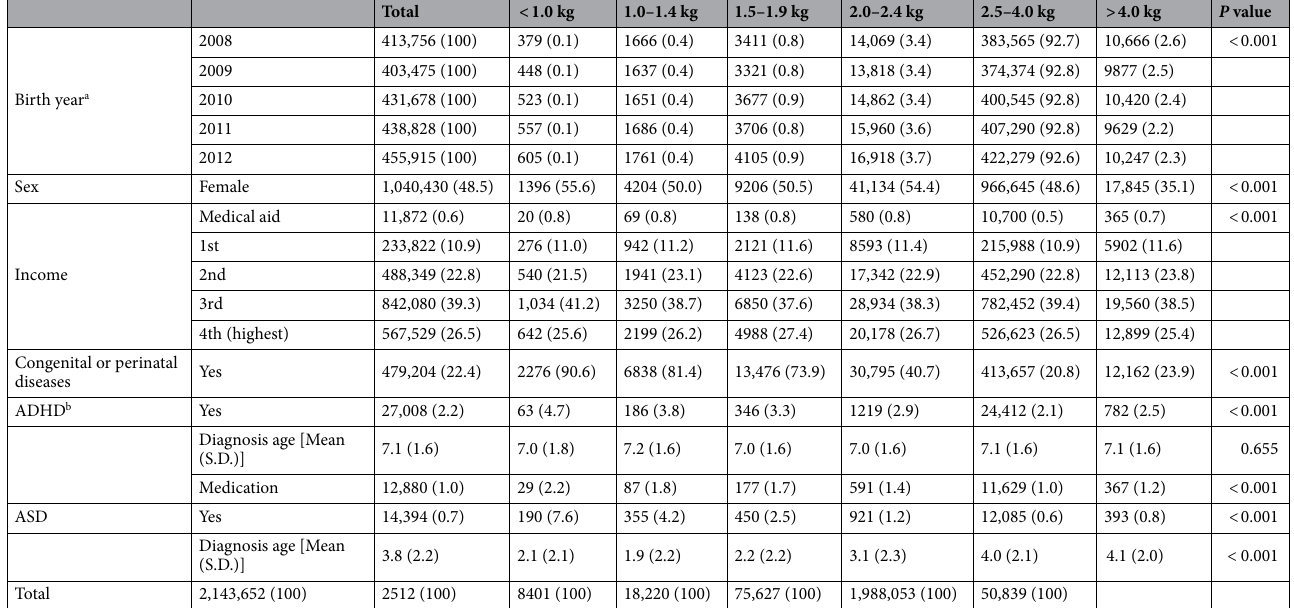
Table 1. Demographics and proportion of children diagnosed with ADHD and ASD born between 2008 and 2012 in the Republic of Korea (n, %). ADHD attention-deficit/hyperactivity disorder, ASD autism spectrum disorder, S.D. standard deviation. a The proportion by birth weight group was calculated using the annual number of births as the denominator. b The analysis of ADHD included children born between 2008 and 2010, taking the average age at ADHD diagnosis (n = 1,248,909) into account.